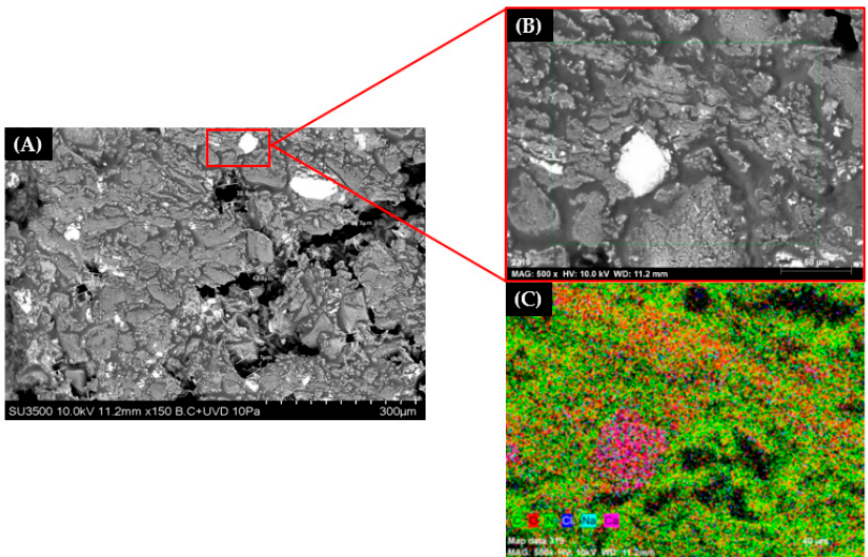
Figure 3. Scanning electron microscopy of a fish feed pellet infused with antigen alginate microparticles. ( A ) original micrograph at 150×; ( B ) 500× magnification; ( C ) elemental mapping at 500× magnification. Table 3. Feed intake rates for experimental diets (low dose oral vaccine, high dose oral vaccine, injectable vaccine) during the vaccination period and throughout the trial. Feed Intake (%) Feed Intake Group during Vaccination Period